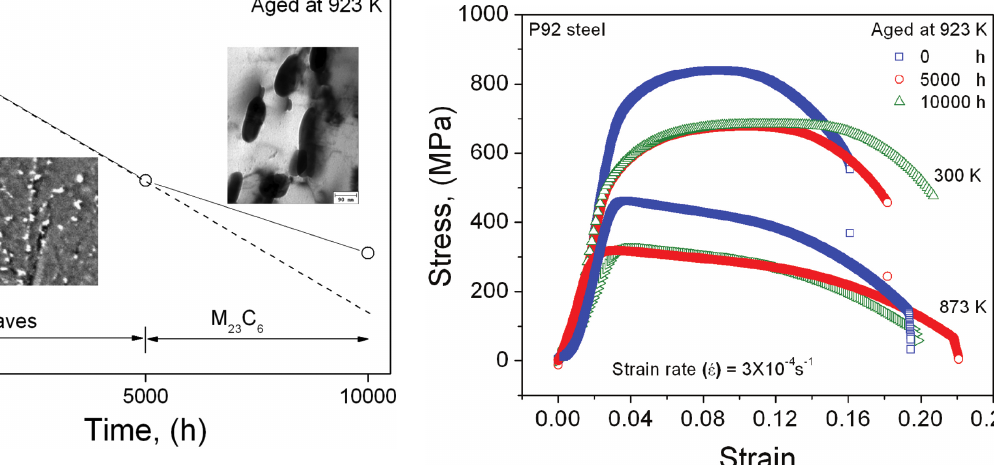
Figure 6: Variations of hardness with different conditions of P92 steel. The decrement shows different rate after 5000 h. Insert micrograph depicts the dominant precipitation which influences the hardness decrement.